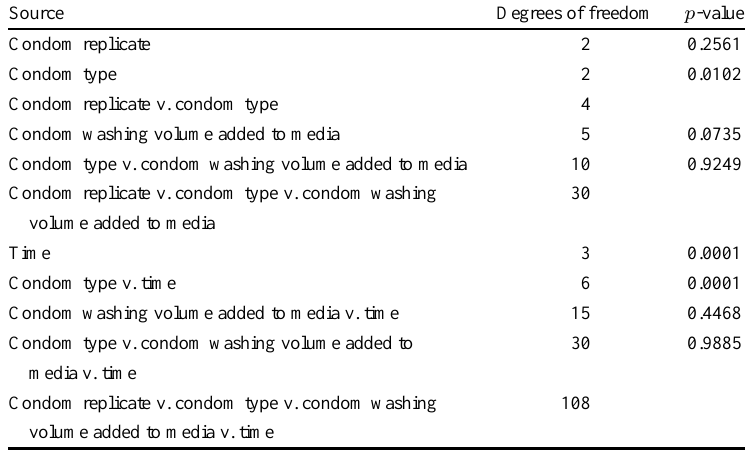
Analysis of variance table for cell survival (Crystal Violet assay)